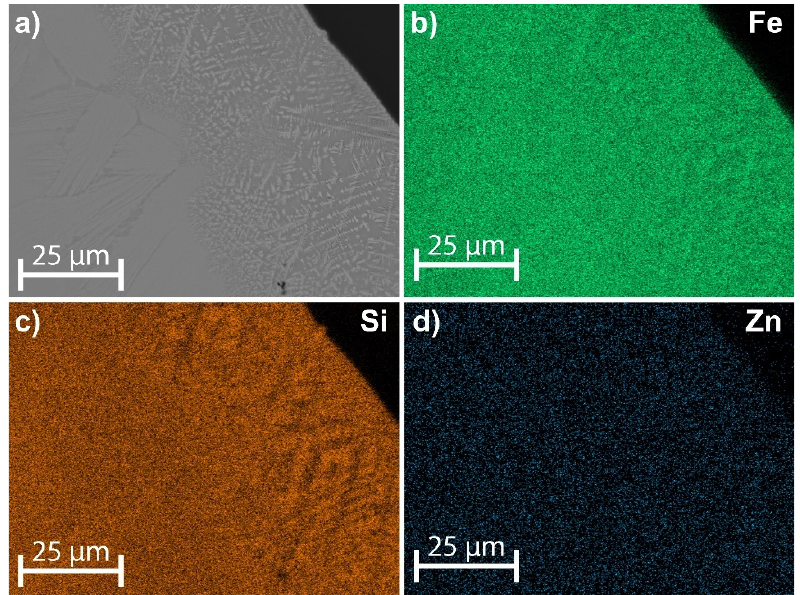
Figure 3. ( a ) SEM image including FeO X crystals and matrix for ZFS13-01, and the distribution of ( b ) Fe, ( c ) Si, and ( d ) Zn.